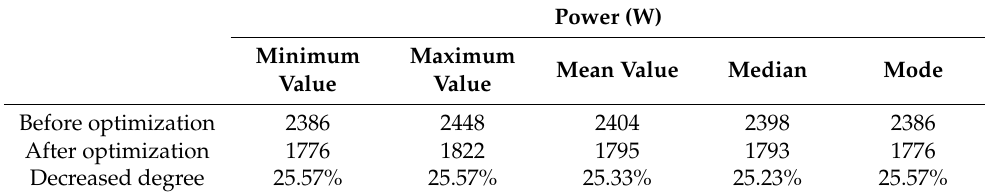
Figure 7. Chopping power consumption of each point on the blade line. Table 2. Statistical